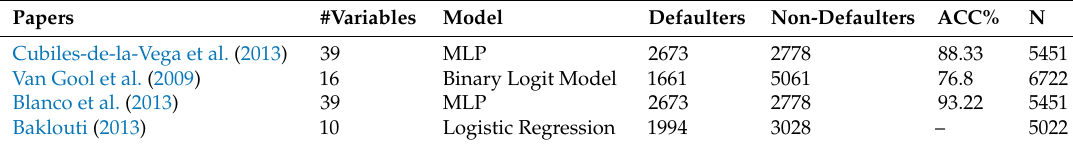
Table 1. Summary of best performing